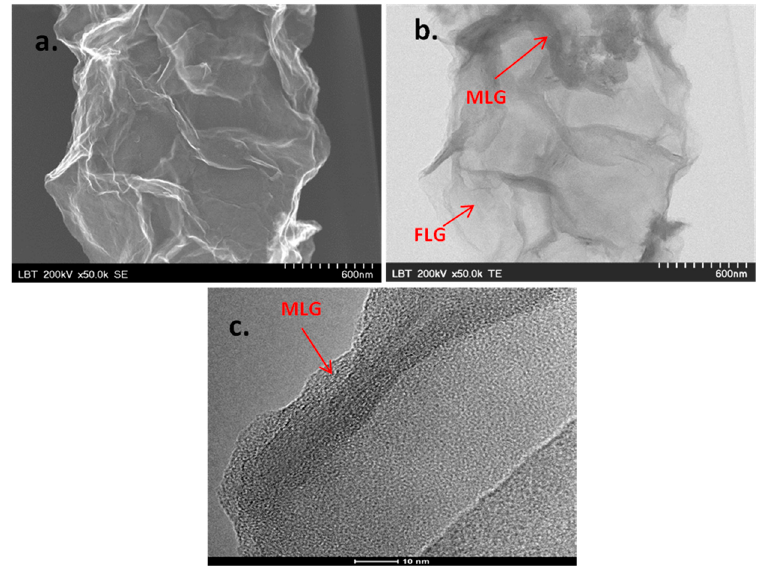
Figure 2. SEM image of the graphene sample—scale bar 600 nm ( a ); TEM image of the sample, revealing few- and multi-layer graphene—scale bar 600 nm ( b ); HR-TEM image of the edge of multi-layer graphene—scale bar 10 nm ( c ).